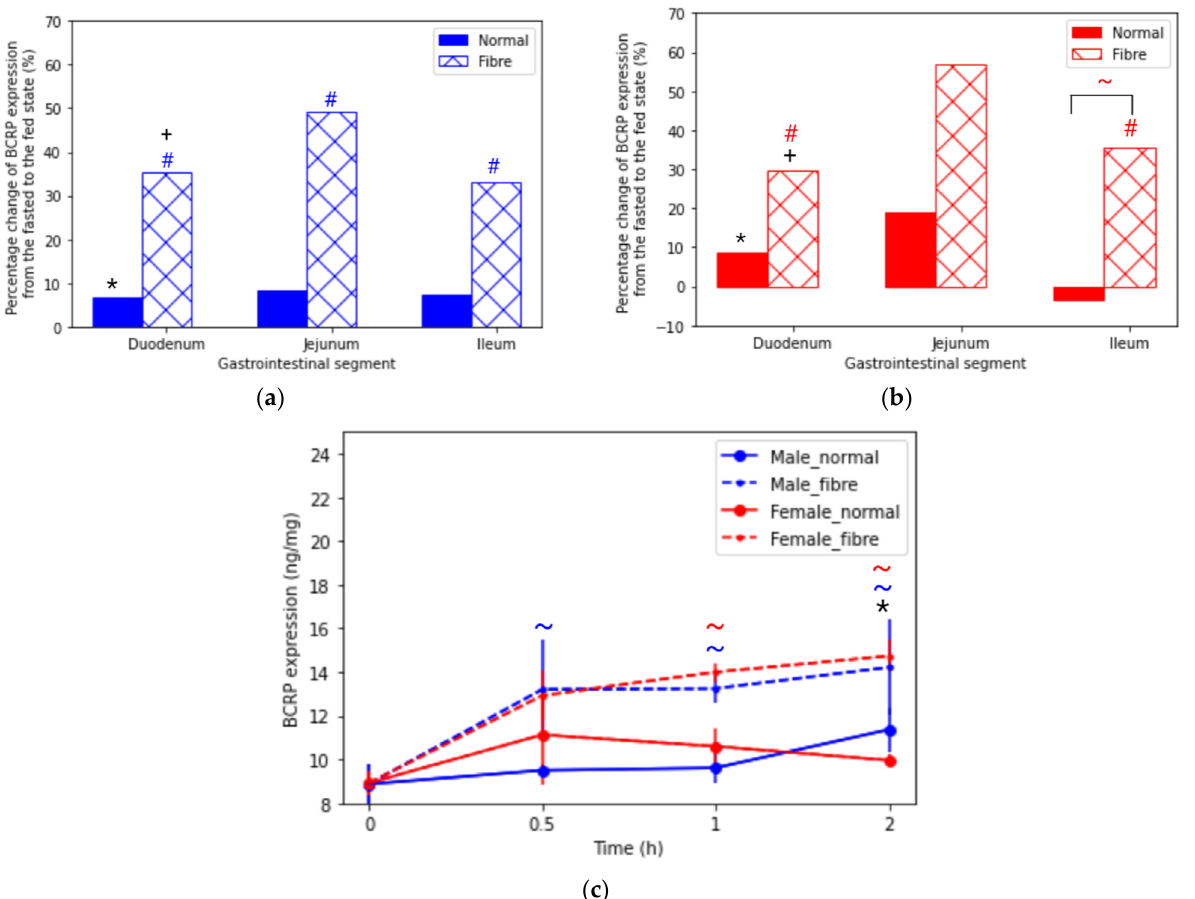
Figure 2. Percentage change in breast cancer resistant protein (BCRP) expression across the intestinal tract in ( a ) male and ( b ) female rats at time = 1 h from the fasted state to the fed states (normal meal and fibre meal). ( c ) BCRP expression in the jejunum from time 0 to 2 h under fasted and fed states (normal meal and fibre meal) (mean ± SD) ( n = 6). The following symbols denote a statistical significance ( p < 0.05) showing a sex difference between male and female rats: normal meal (*) and fibre meal (+); and a food effect between the feeding interventions: fasted and fibre (#) and normal and fibre (~).